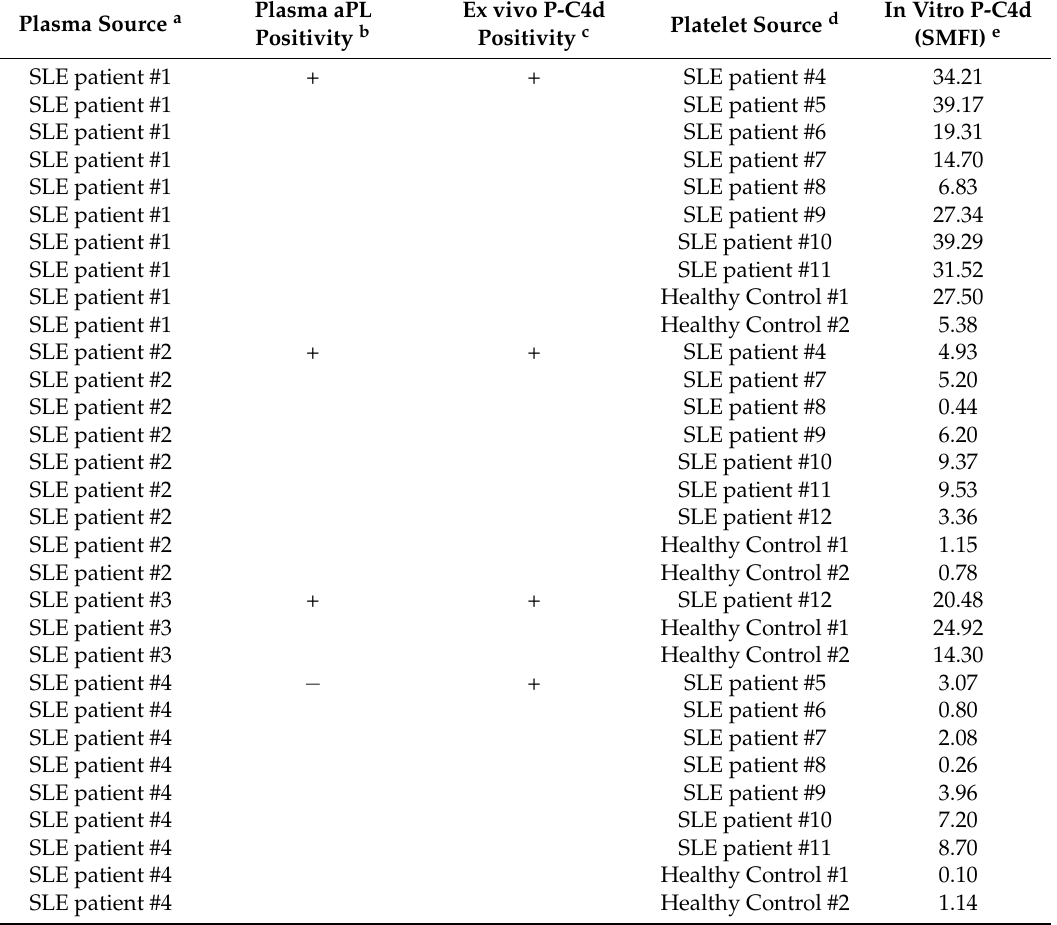
Table 5. Comparison of the capacity of aPL+ and aPL − SLE plasma to induce P-C4d in